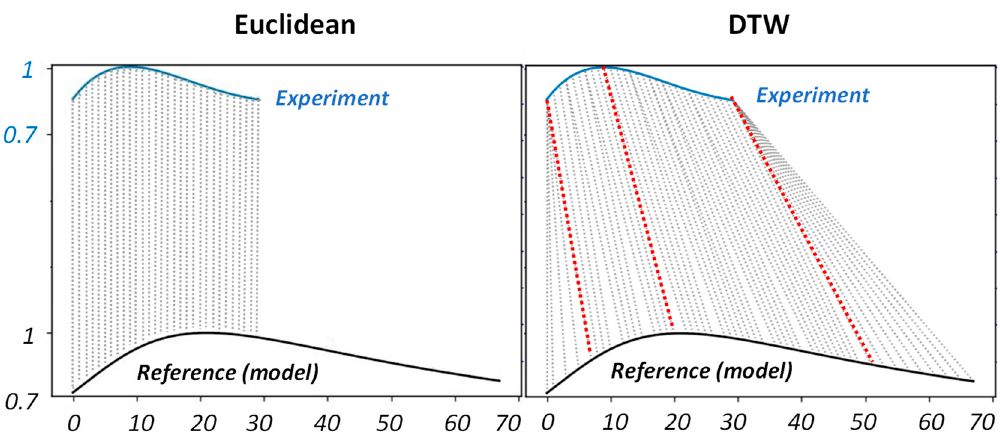
Figure 15. A comparison of Euclidean and DTW alignments of experimental and analytical model of running contrast curve for defect 𝐷 = 22 mm , 𝑑 = 1 mm . running contrast curve for defect D = 22 mm, d = 1